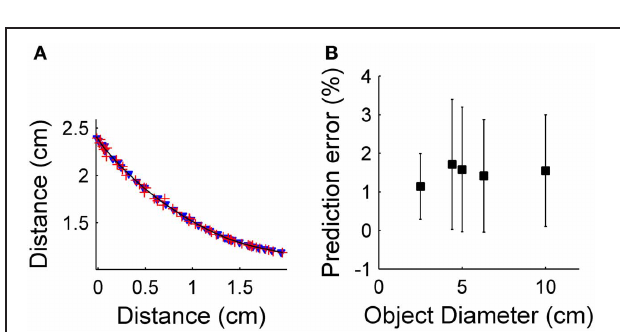
left is five times longer than the length of the spiral on the right. (C) Quantification of the increased prediction error as the scale of the object decreases relative to inter-vibrissal spacing. Whisker spacing is normalized by the length of the object. As relative vibrissal spacing increases, error increases linearly.